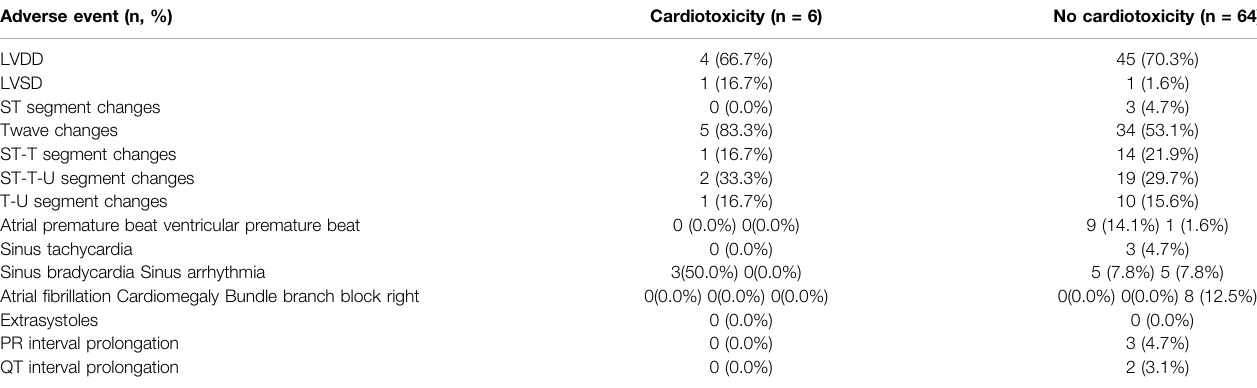
TABLE 6 | Cardiac disorders (NCI-CTCAEv4.0, all grades). Adverse event (n,